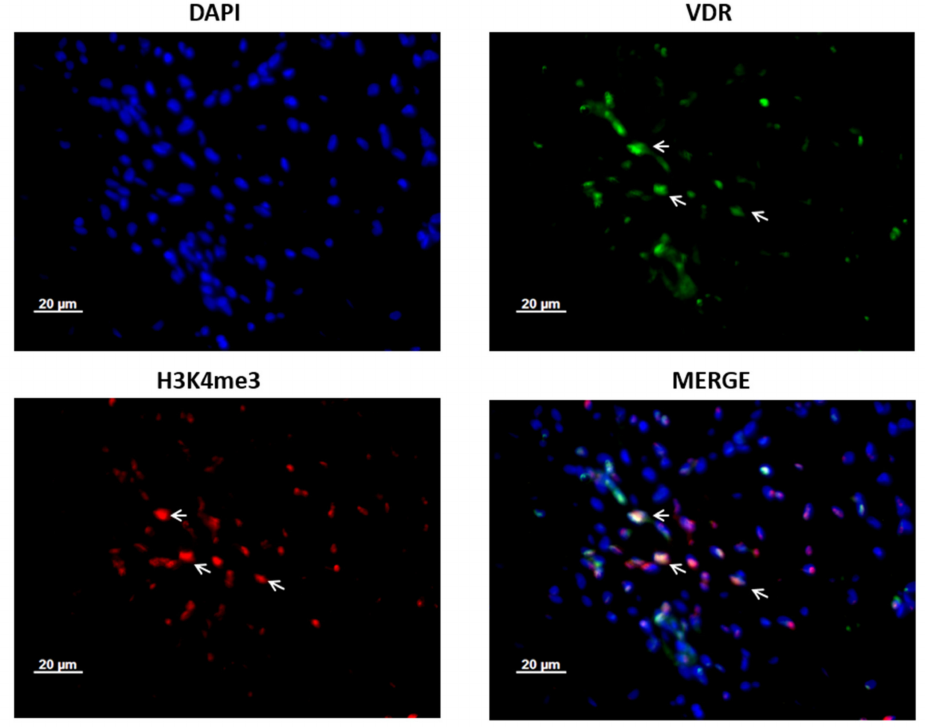
Figure 3. H3K4me3 is co-expressed with vitamin D receptor (VDR) in ovarian cancer patients’ tissue. Co-expression of VDR and H3K4me3 proteins is shown with → . Magnification × 40, scale bar = 20 µ m. Tissues were co-stained with 4 (cid:48) ,6-diamino-2-phenylindole (DAPI) (blue), H3K4me3 (red), and VDR